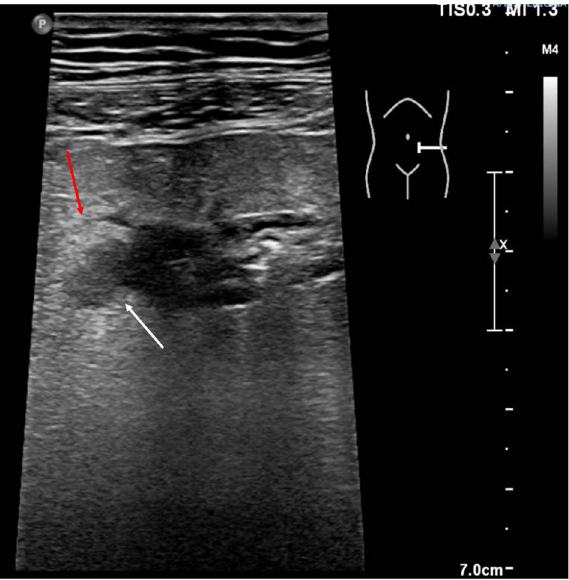
Figure 9. Image obtained by a linear probe. There is evidence of bowel wall thickening and parietal outpouring (white arrow) of a section of the descending colon, compatible with a diverticulum. The hypoechoic formation extends into the surrounding fatty tissue, which appears hyperechoic (red arrow). The findings appear indicative of acute diverticulitis.